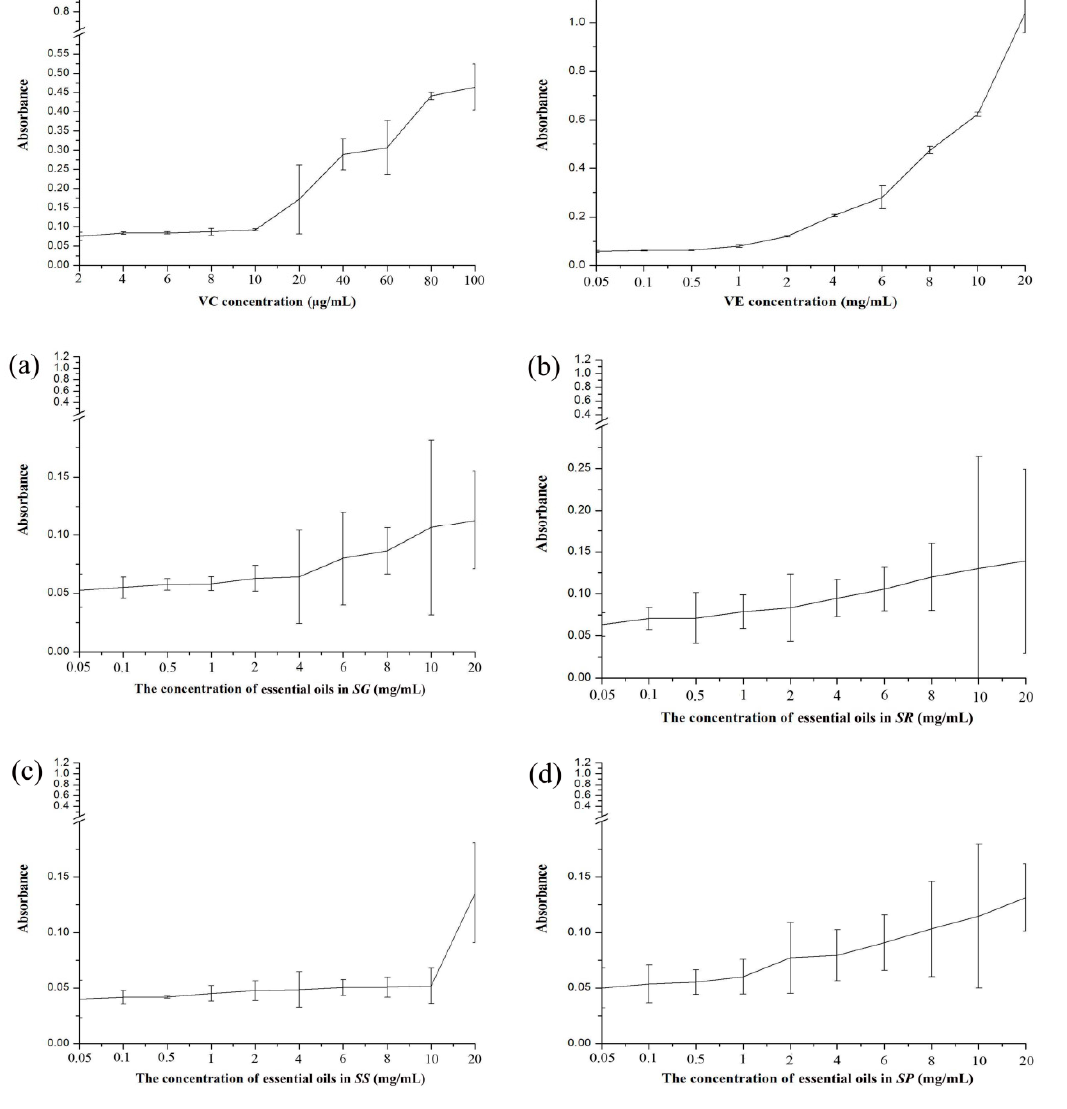
Figure 4. The results of reducing power assay of essential oils from four species (( a ) SG ; ( b ) SR ; ( c ) SS ; ( d ) SP ).